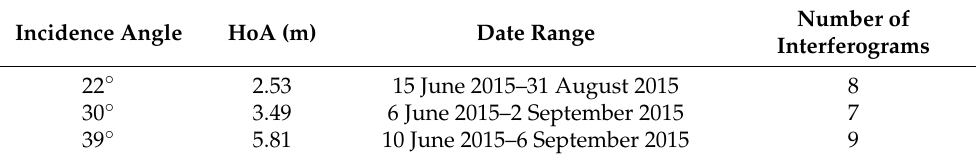
Table 2. TanDEM-X system parameters and acquisition dates for the datasets from Seville. Incidence Angle HoA